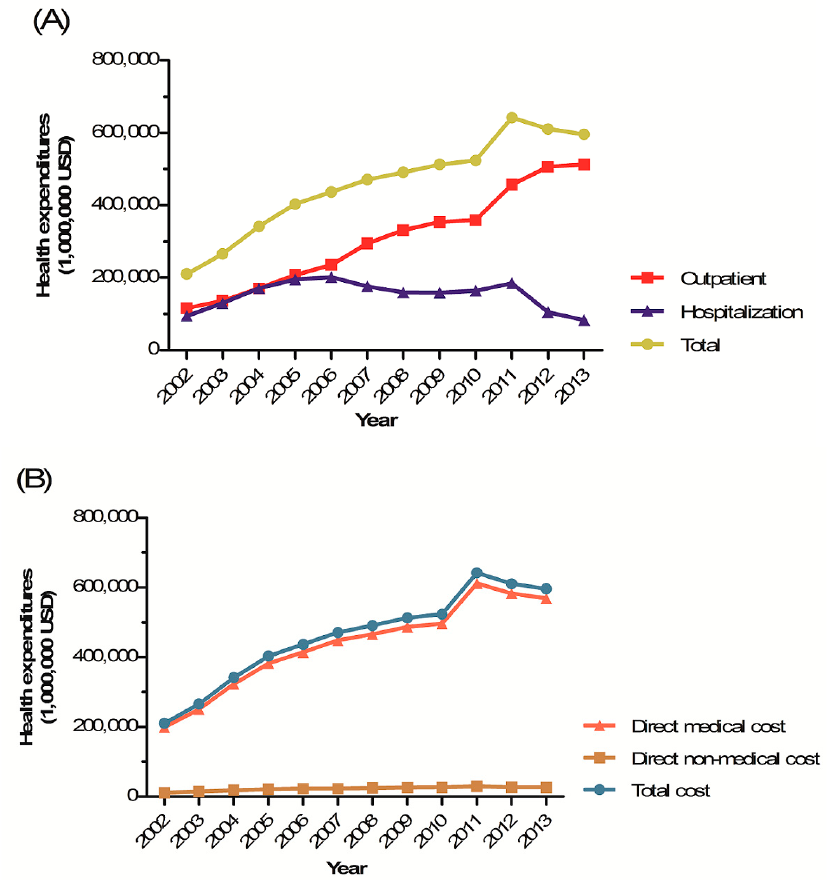
Figure 2. Health expenditures of iron deficiency anemia in Korea, 2002–2013. ( A ) Health expenditures of iron deficiency anemia in accordance with service types. ( B ) Health expenditures of iron deficiency anemia in accordance with cost types.